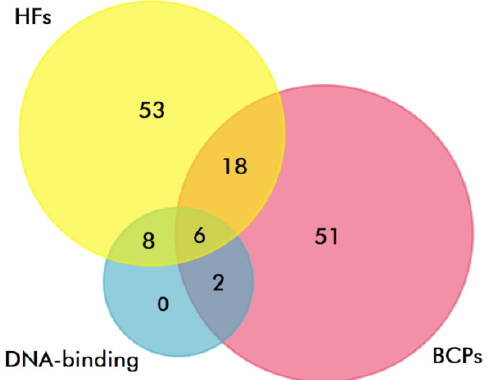
Figure 6. Venn–Euler diagram of DNA-binding proteins in plasma exosomes from HF and BCP blood, composed using QuickGO and FunRich software. Several DNA-binding domains have been identified in DNA-binding exosomal proteins (Table 2). Table 2. DNA-binding exosomal proteins.